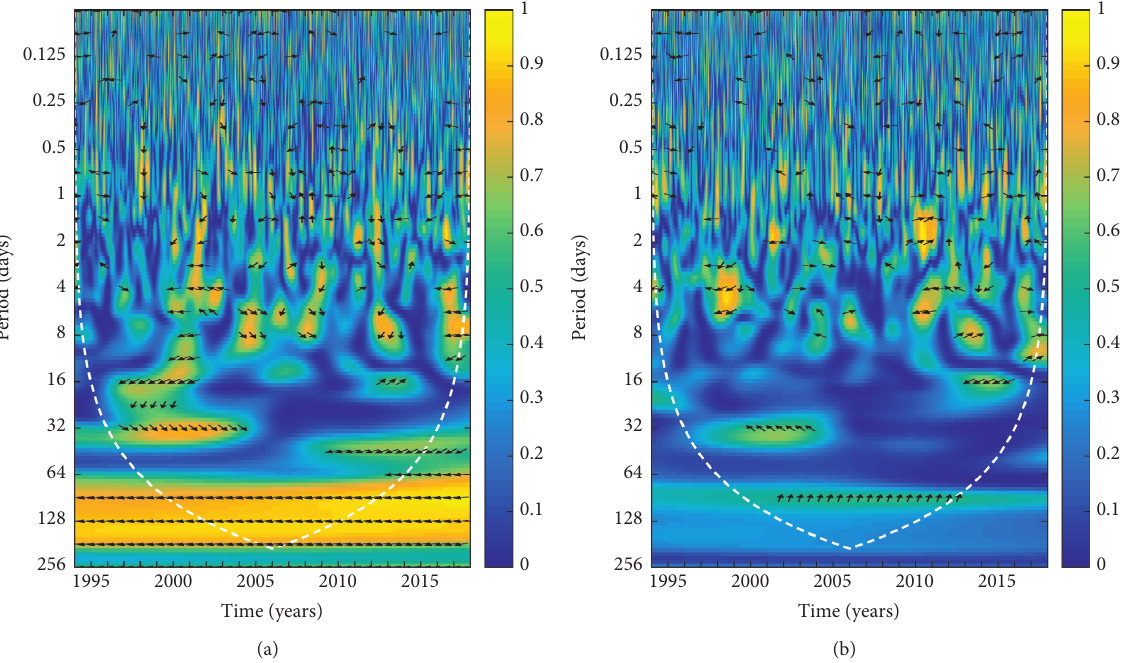
Figure 7: The wavelet coherence analysis for between sunspot numbers and cosmic ray intensity (a) and for between sunspot numbers and solar wind speed (b). For more details, see the context.